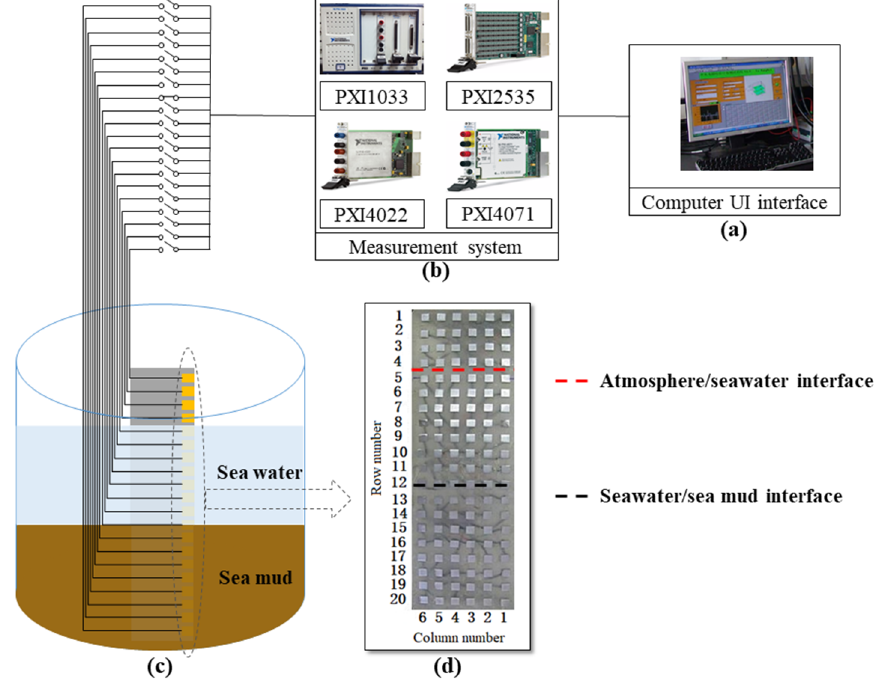
Figure 1. Schematic diagram of the experimental setup. ( a ) Computer console. ( b ) Measurement system. ( c ) Experimental device. ( d ) Photo of the WBE before applying the coating on the surface.